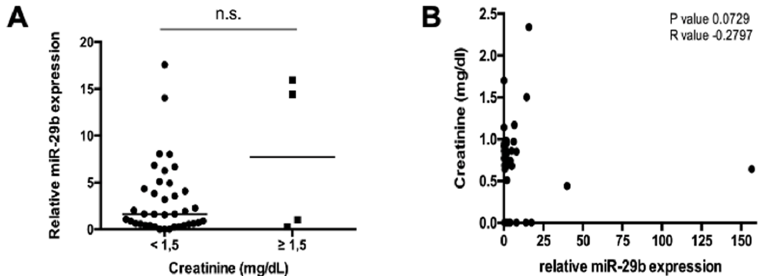
Figure 3. miR-29b levels in NET are not indicative for kidney injury. ( A ) Analysis of miR-29b serum levels with respect to an impaired kidney function. ( B ) Spearman’s rank analysis does not reveal a significant correlation between creatinine values and relative miR-29b concentration in serum levels of NET patients. The scatter plots display relative miR-29b expression levels between the two subgroups. The black horizontal line represents the median per group (* p < 0.05; ** p < 0.01; *** p < 0.001).